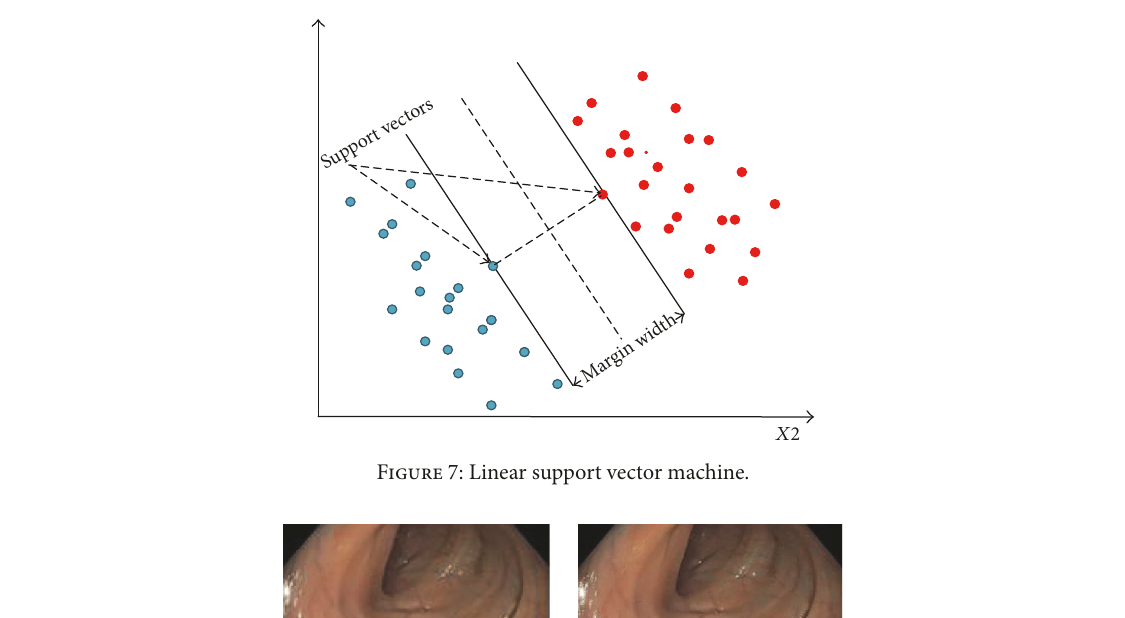
Figure 6: An illustration of the proposed CNN feature extraction segment.